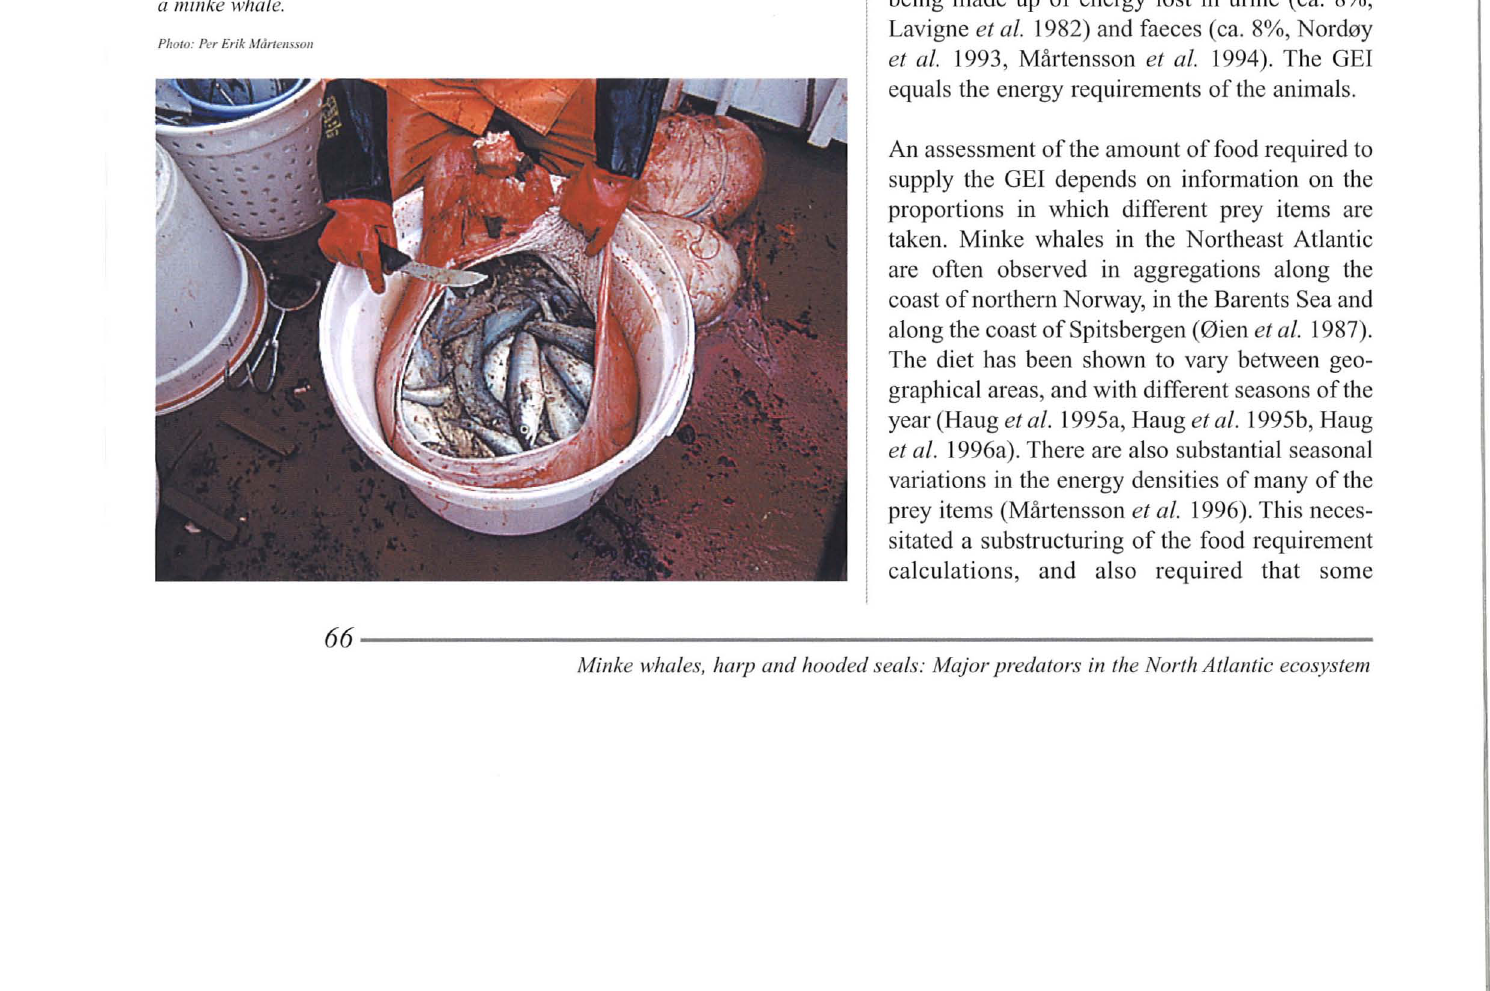
Fig. I: Stolllach cOlltellts of a lIIillke